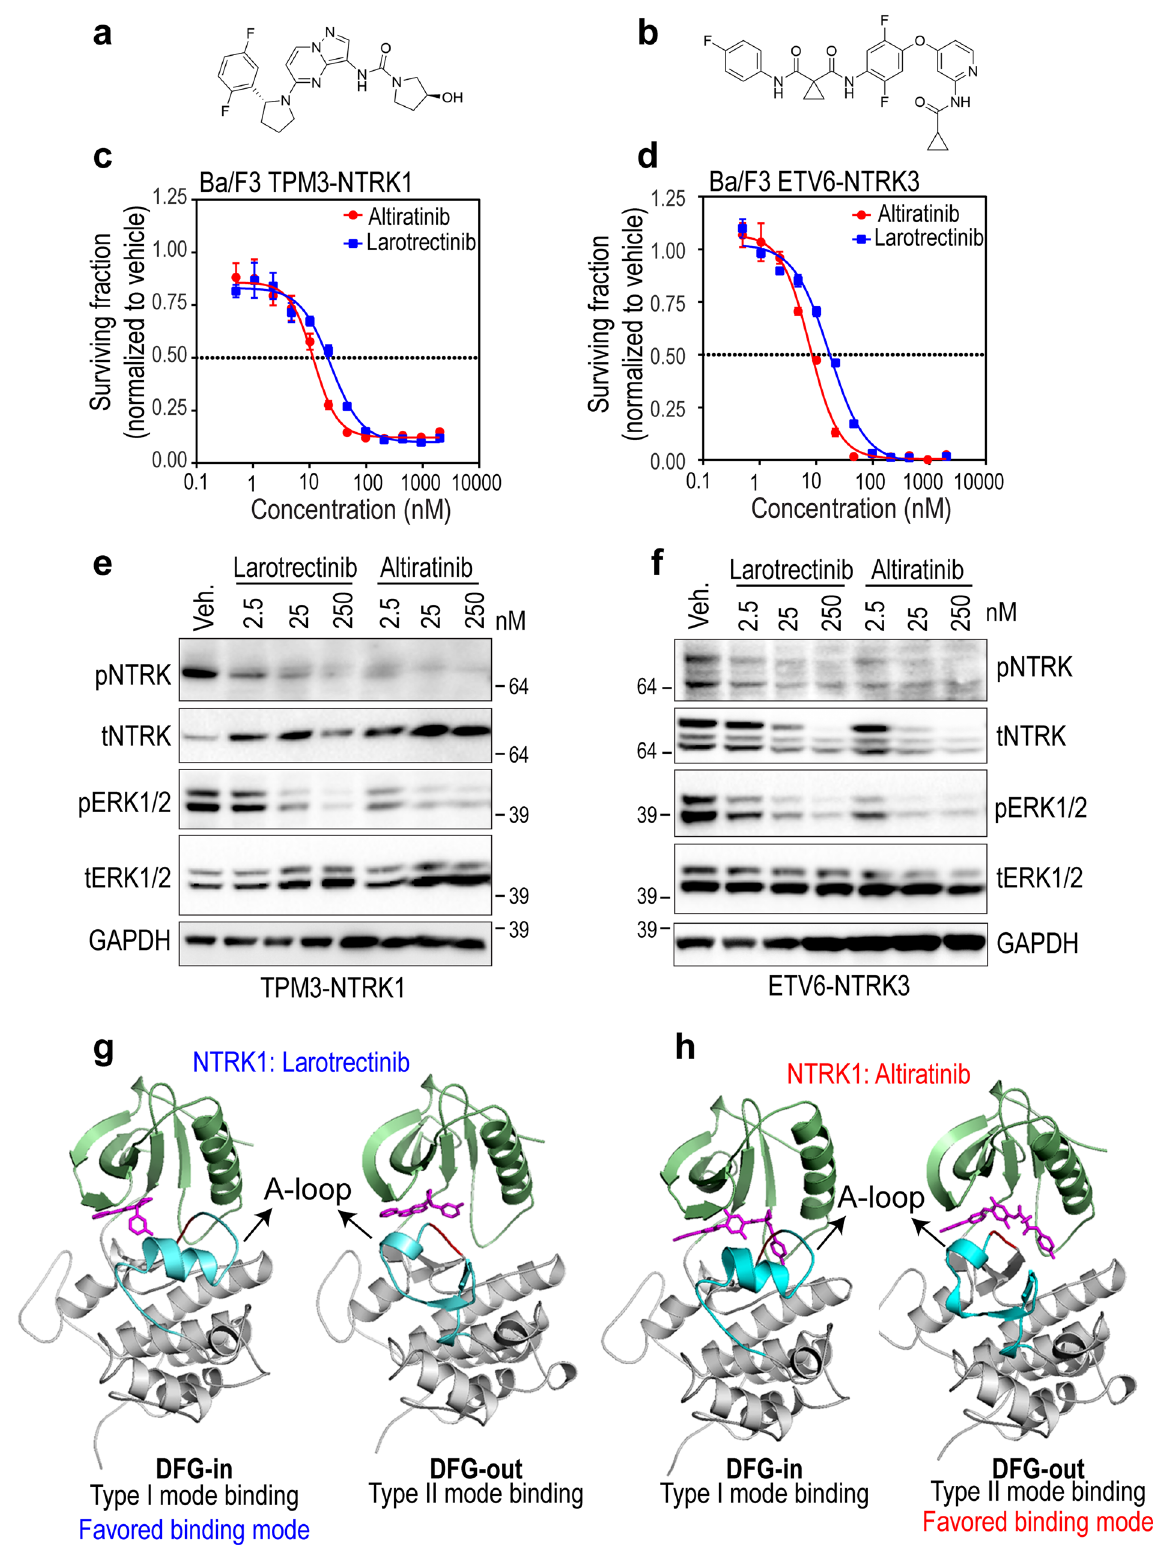
Fig. 1 In vitro ef fi cacy and structural basis of binding of larotrectinib and altiratinib for NTRK fusion proteins. Chemical structures of larotrectinib ( a ), and altiratinib ( b ). Dose-response cell viability of onco-addicted Ba/F3 TPM3-NTRK1 ( c ) or ETV6-NTRK3 fusion ( d ) expressing cells after treatment with larotrectinib or altiratinib for 72 h. Representative data are average ± standard error of means (SEM) from three independent replicates. e , f Immunoblot analysis of TPM3-NTRK1 and ETV6-NTRK3 autophosphorylation (pNTRK), as well as Erk1/2 phosphorylation (pErk1/2), corresponding total NTRK (tNTRK) and Erk1/2 (tErk1/2) levels, and loading control (Gapdh). “ Veh. ” indicates vehicle (dimethyl sulfoxide (DMSO)) treatment. Data are representative of four independent experiments. Structural homology models of NTRK1 in DFG-in (type I) or DFG-out (type II) conformations bound to larotrectinib ( g ) or altiratinib ( h ); type I and type II are the favored binding modes for larotrectinib and altiratinib,